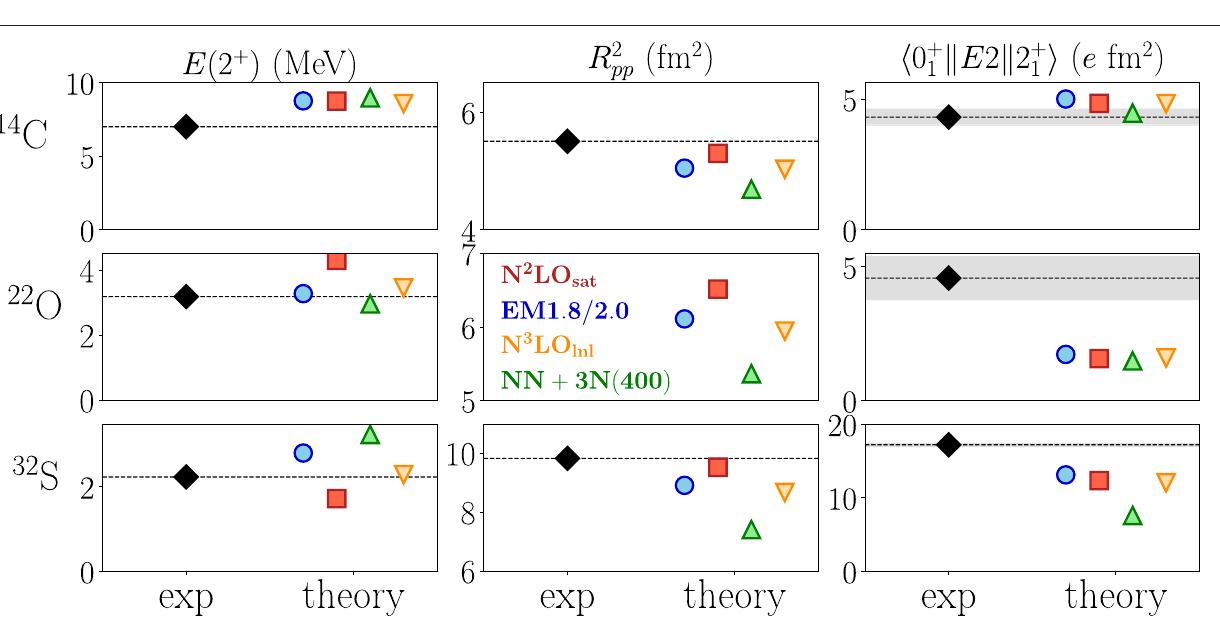
FIGURE 10 | Energies of the first excited 2 + state, proton mean square radius and quadrupole transition matrix elements for selected nuclei, based on VS-IMSRG(2) calculations with multiple chiral NN+3N interactions. See references [76] and [230] for more details. Experimental values (with uncertainties indicated by bands) are taken from [227, 233]. Figure courtesy of R.